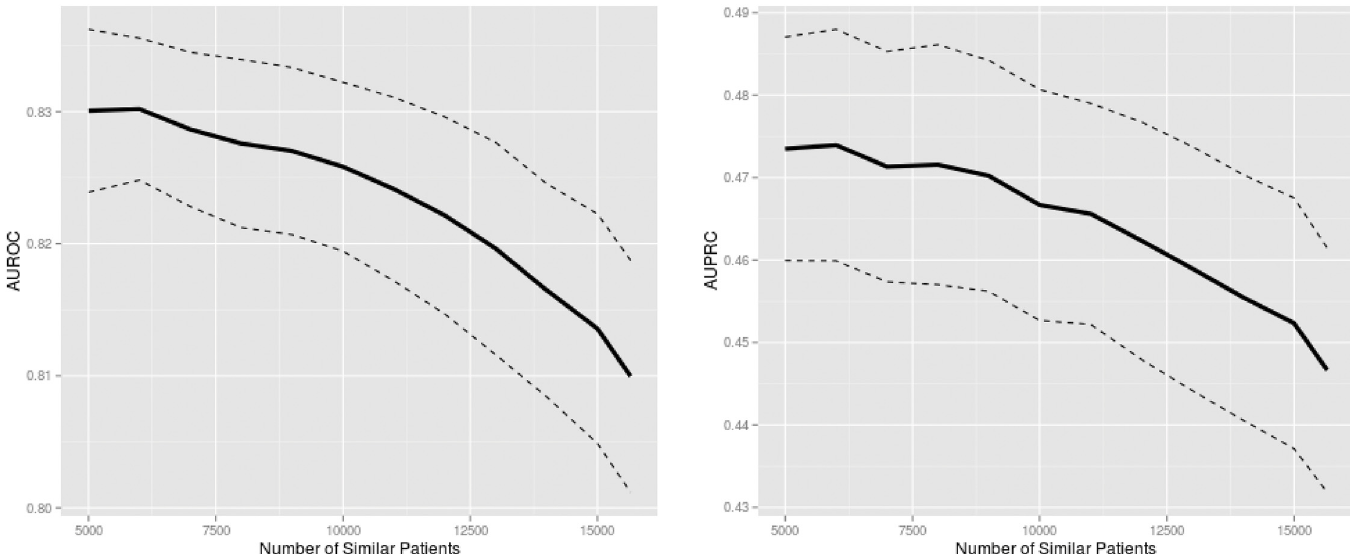
Fig 2. Mortality prediction performance of personalized logistic regression trained on similar patient data. The solid and dashed lines are the mean and 95% confidence intervals, respectively, from 10-fold cross-validation. The maximum number of similar patients corresponds to all available training data. Predictive performance clearly improves as data from fewer but more similar patients are used for training. Identical predictor values in training data prohibited decreasing the number of similar patients further. AUROC: area under the receiver operating characteristic curve; AUPRC: area under the precision-recall curve.